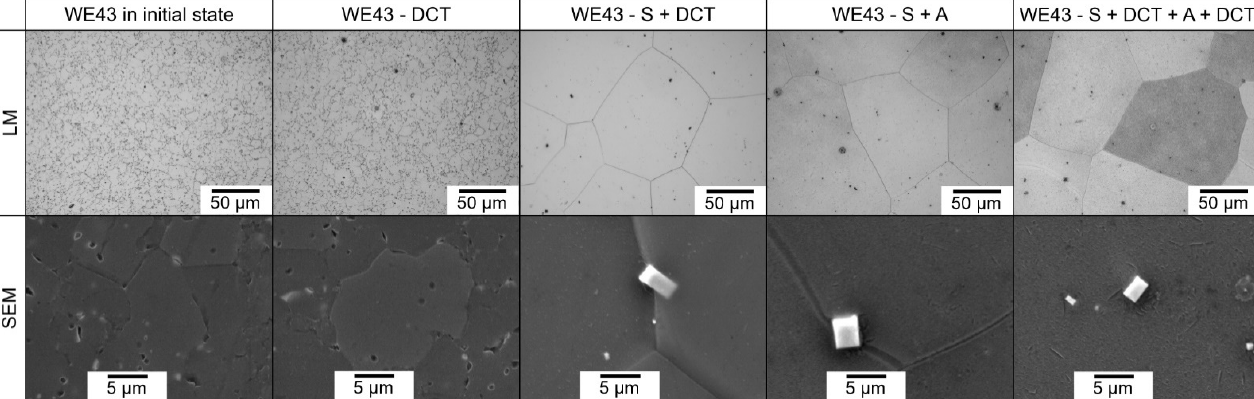
Figure 5. Microstructure of the WE54 magnesium alloy in the initial state, after deep cryogenic treatment (DCT), after solution treatment and deep cryogenic treatment (S + DCT), after solution treatment and aging (S + A), and after precipitation hardening combined with deep cryogenic treatment (S + DCT + A + DCT).